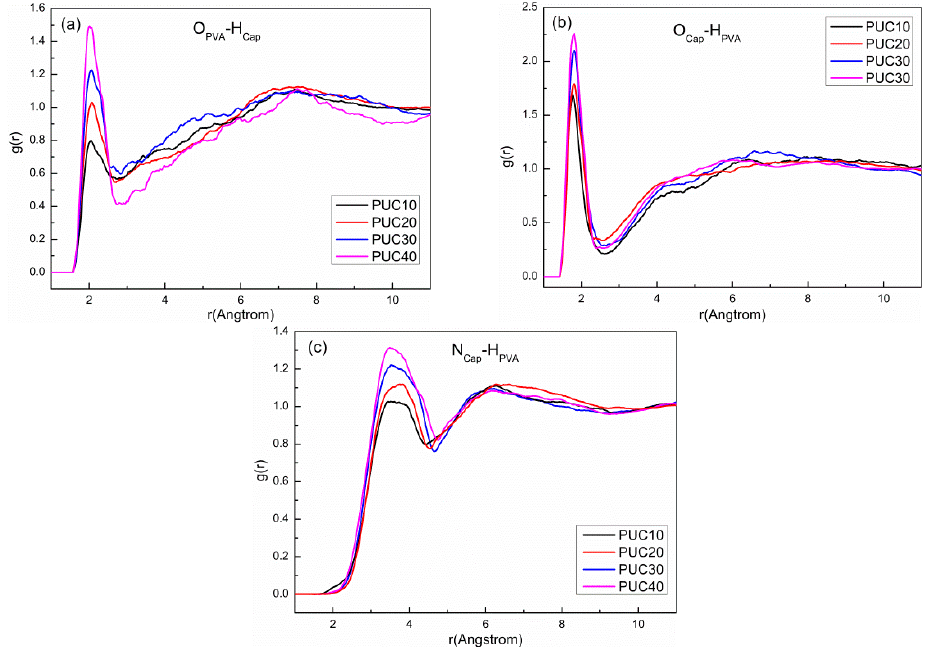
values of the PCFs between O PVA - H Cap and O Cap - H PVA at nearby r = 2.02 Å and r = 1.78 Å